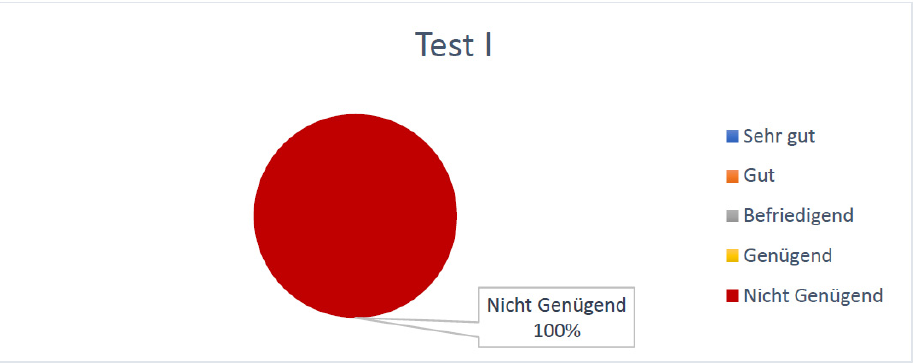
Figure 2. Percentual grade distribution of tests taken by the students before the SIMline course. At the second test (taken after the simulation training) students achieved an average of 44.1 points ( ± 6.1) out of 64 and thus showed an average improvement of 88%. According to the equivalence key for grades, only 13% of the students were assessed with “Nicht genügend”/“F” after the second exam (Figure 3). The same percentage of participants was graded with a “Gut”/“B” after the final test, over 1/3 received a “Befriedigend”/“C” and 40% improved to a “Genügend”/“D”.